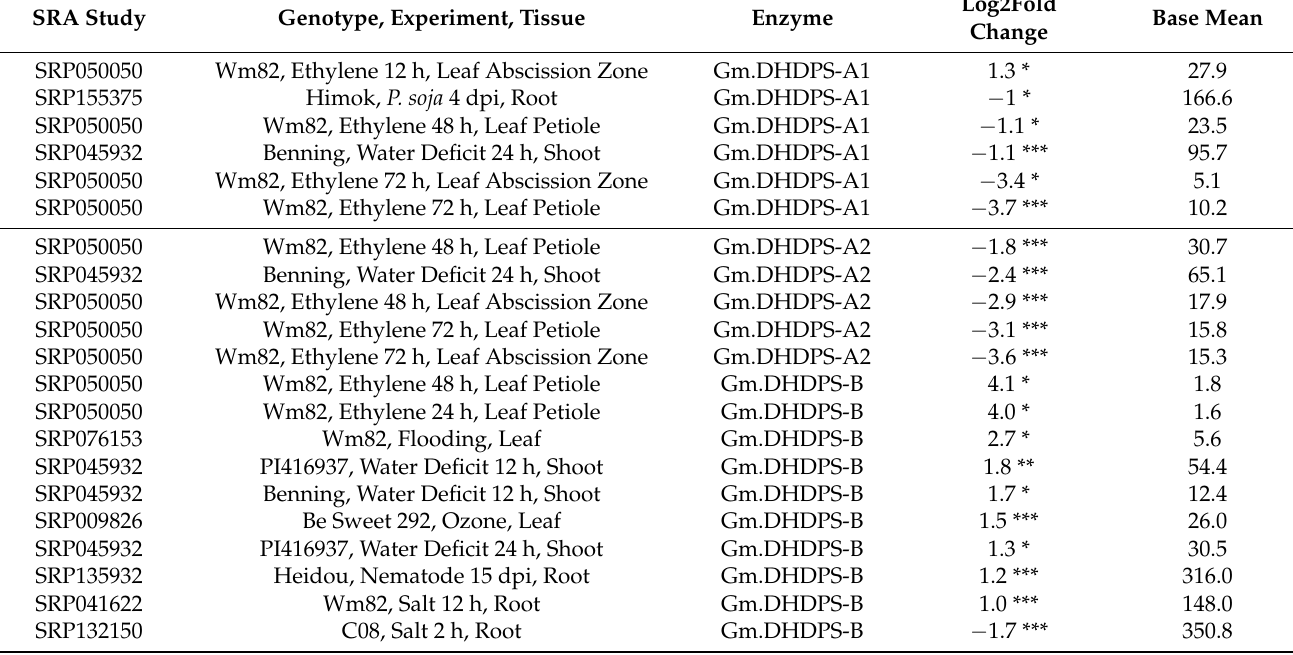
Table 3. Significant differential expression values only (DESeq Wald test, * = p < 0.05, ** = p < 0.01, *** = p < 0.001) for DHDPS only from the re-analyzed 23 biotic and 70 abiotic stress experiments in soybean. SRA Study ID, soybean genotype, experiment within the SRA study, tissue type, enzyme ID, Log2Fold change, and base mean (mean over control and treatment samples) are given. Cut-off values for Log2Fold change values were set to +1 for upregulated genes and − 1 for downregulated